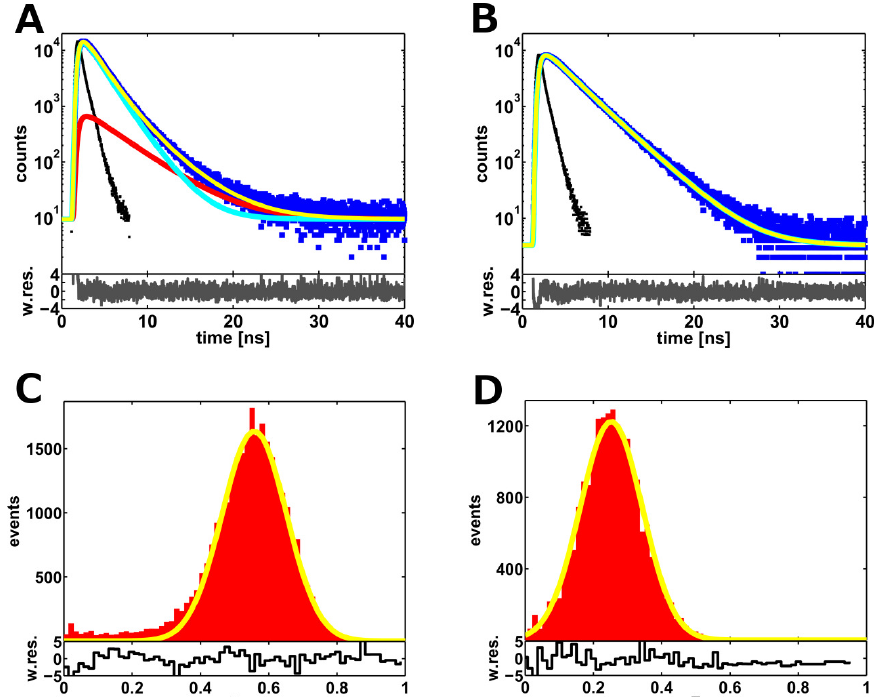
Figure 4. ( A , B ) FRET-filtered lifetime decays for 10-bp and 17-bp DNA samples. Here, the same color code is used as in Figure 3. The fitting parameters are reported in Table 1. ( C , D ) Efficiency histograms corresponding to the data given in the upper line are fitted with shot-noise limited Gaussian